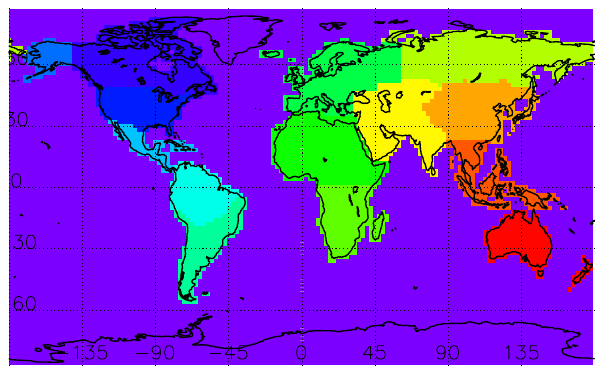
Fig. 6. The 14 land regions and rest of the world (ROW) used in the inversion example, from Nassar et al.